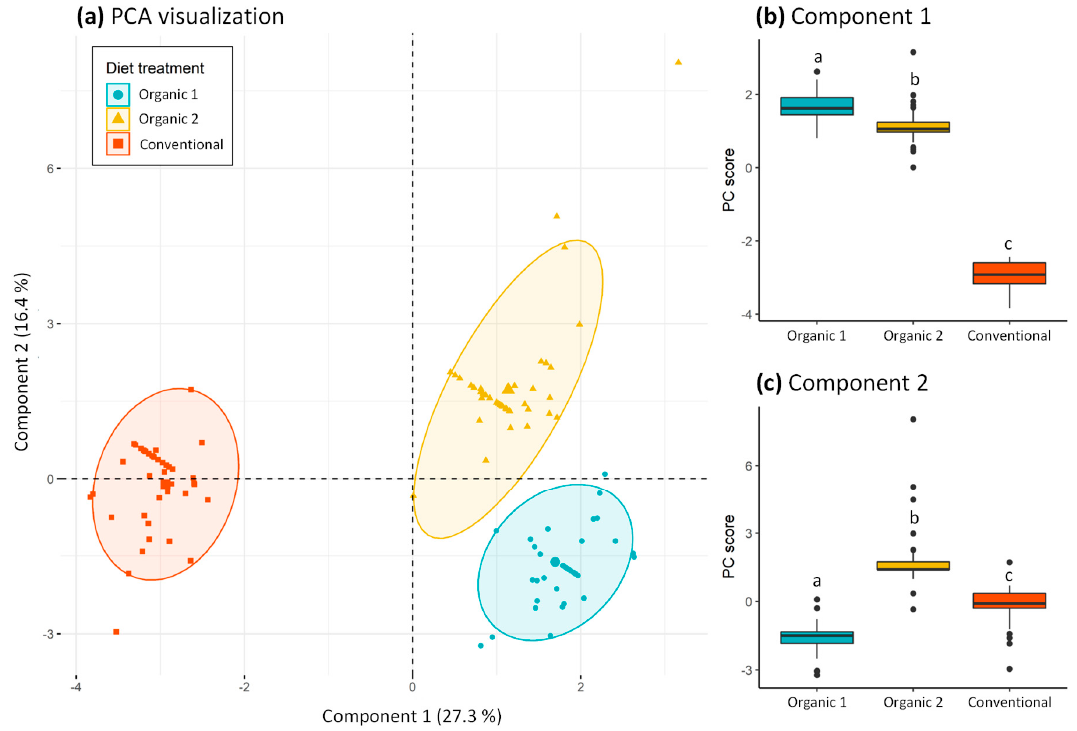
Figure 4. Principal component analysis. ( a ) Visualization of the individual positioning of the individual on the PCA as a function of diets. Confidence ellipses drawn around the levels of the categorical variable diet treatment with a confidence level of 0.95; ( b ) Individual PC score for the first component as a function of diet treatment; ( c ) Individual PC score for the first component as a function of diet treatment. Both for ( b , c ), different letters indicate groups significantly different (Tukey HSD, p < 0.05).